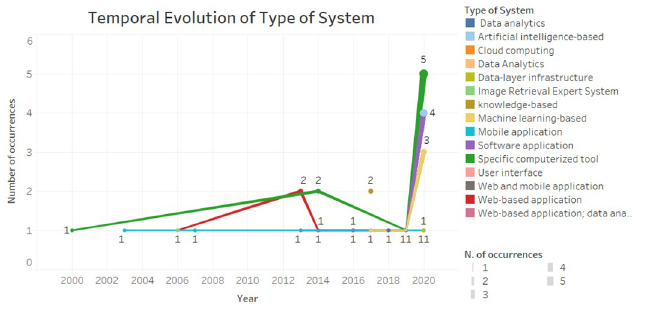
Fig 6. Temporal evolution of type of